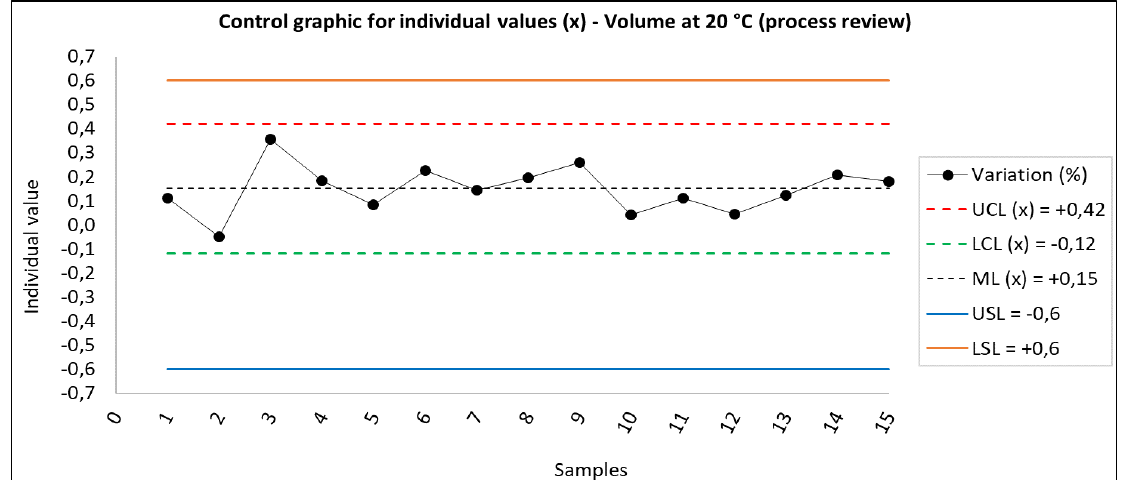
Figura 11: Control chart of individual values ( x ) - Volume at 20 °C - process review. Source: Authors, (2020).